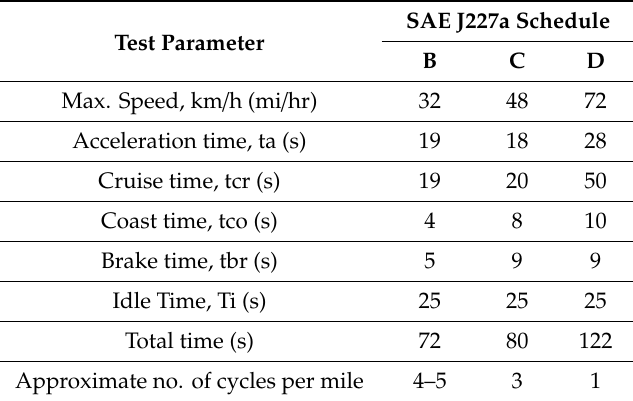
Table 3. Standard driving Schedule, SAE